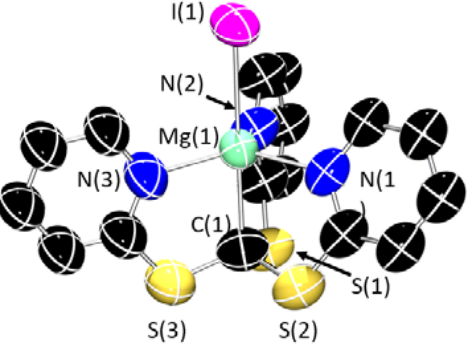
7 of 16 Figure 3. X-ray crystal structures of 1-X (X = Cl, Br, I). Ellipsoids are set at 50% probability level, and hydrogen atoms and lattice solvent molecules have been excluded for clarity. The figures have been reproduced as dimers to fully illustrate the geometry. C: black; N: blue; S: yellow; Mg: aquamarine; Cl: green; Br: brown; I: purple. 1-Cl : The asymmetric unit contains one monomer and half a molecule of benzene. Symmetry operation used to generate equivalent atoms: i = –x, 0.5 + y, 0.5 − z. Selected bond lengths (Å) and angles (°): Mg(1)–C(1) 2.427(11), Mg(1)–N(1) 2.186(11), Mg(1)–N(2) 2.204(10), Mg(1)–N(3) 2.193(11), Mg(1)–Cl(1) 2.427(5), N(1)–Mg(1)-N(2) 87.1(4), N(2)-Mg(1)-N(3) 94.1(4), C(1)- Mg(1)-Cl(1) 178.9(4). 1-Br : The asymmetric unit contains two monomers. Symmetry operation used to generate equivalent atoms: i = 1 − x, 2 − y, 1 − z. Selected bond lengths (Å) and angles (°): Mg(1)-